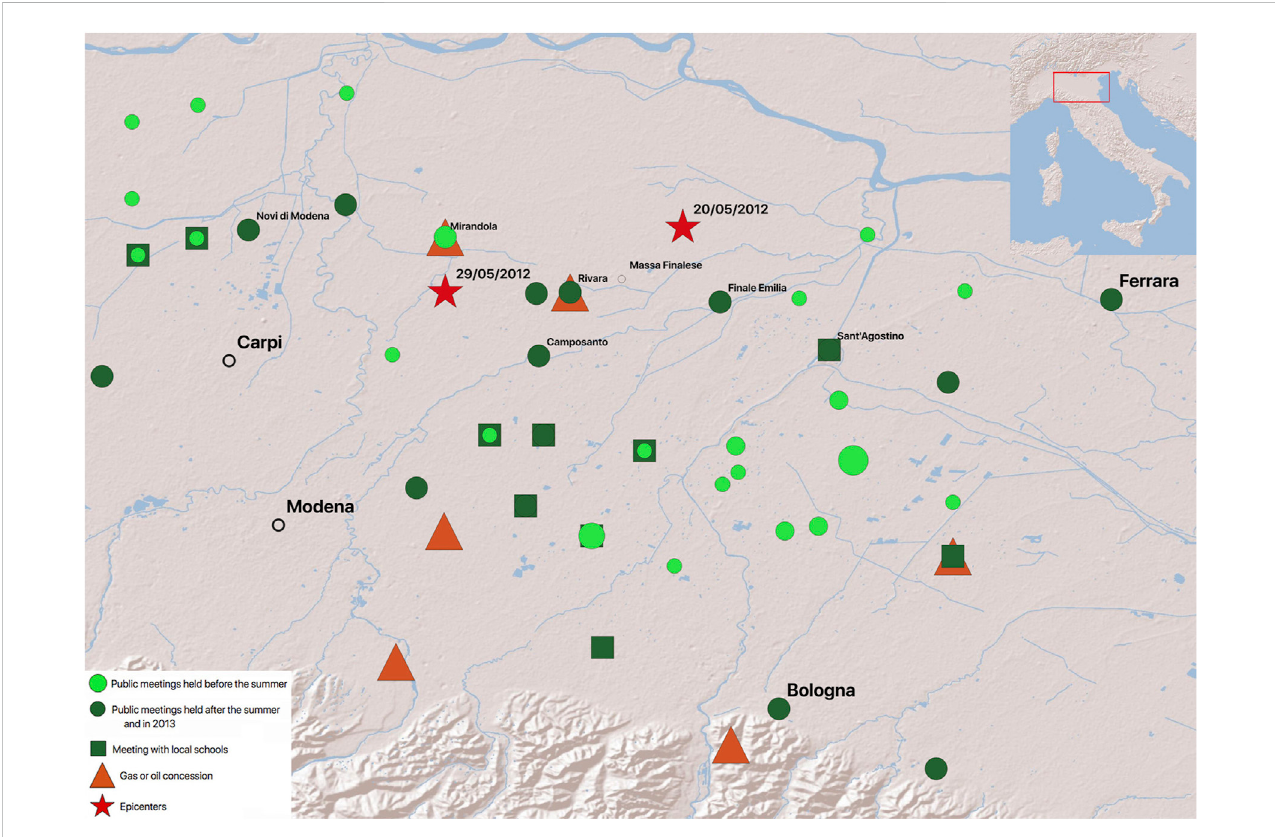
Locations of the public meetings organized in the region affected by the 2012 seismic sequence. The red stars indicate the two major events, on May 20 and 29, 2012. Orange triangles show the location of gas or oil concessions. Green symbols indicate the locations of the public meetings organized during and after the sequence. The size of the symbols re fl ects the number of meetings held at each location, with larger symbols corresponding to 5 encounters. Lightgreensymbolsindicatemeetingsheldduringthesequence(beforethesummer),whiledarkersymbolsshowmeetingsorganizedafterthesummer. Square symbols refer to activities held in local schools, during the 2012/2013 school